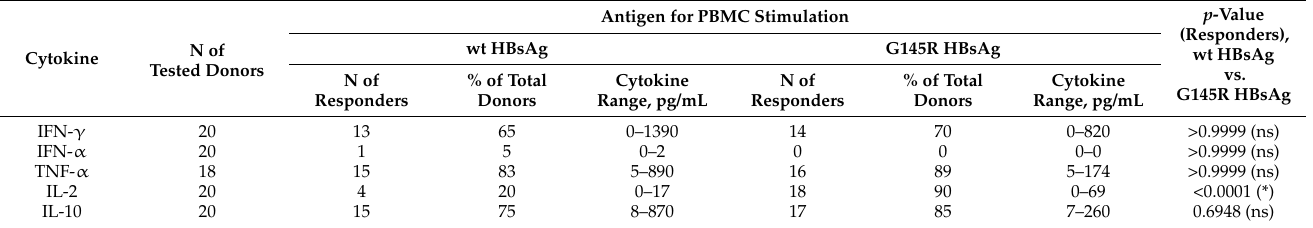
Table 3. Numbers of donors responding to PBMC stimulation with wild-type rHBsAg (ayw2) and the rHBsAg G145R mutant (ayw2) and PBMC cytokine production 1